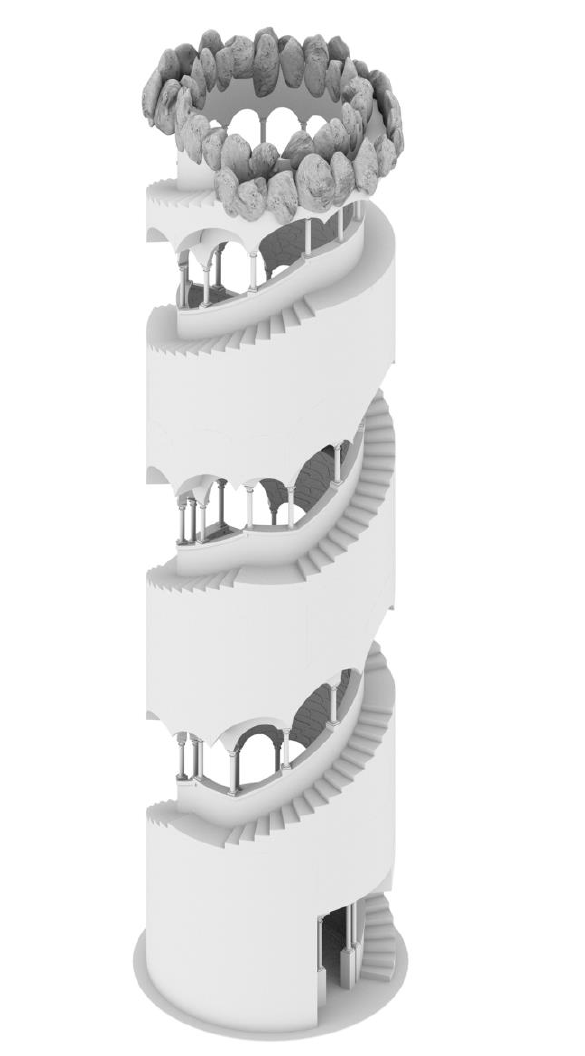
Figure 13 . The Quinta da Regaleira in Sintra, the Poço Iniciatico , digital model of the